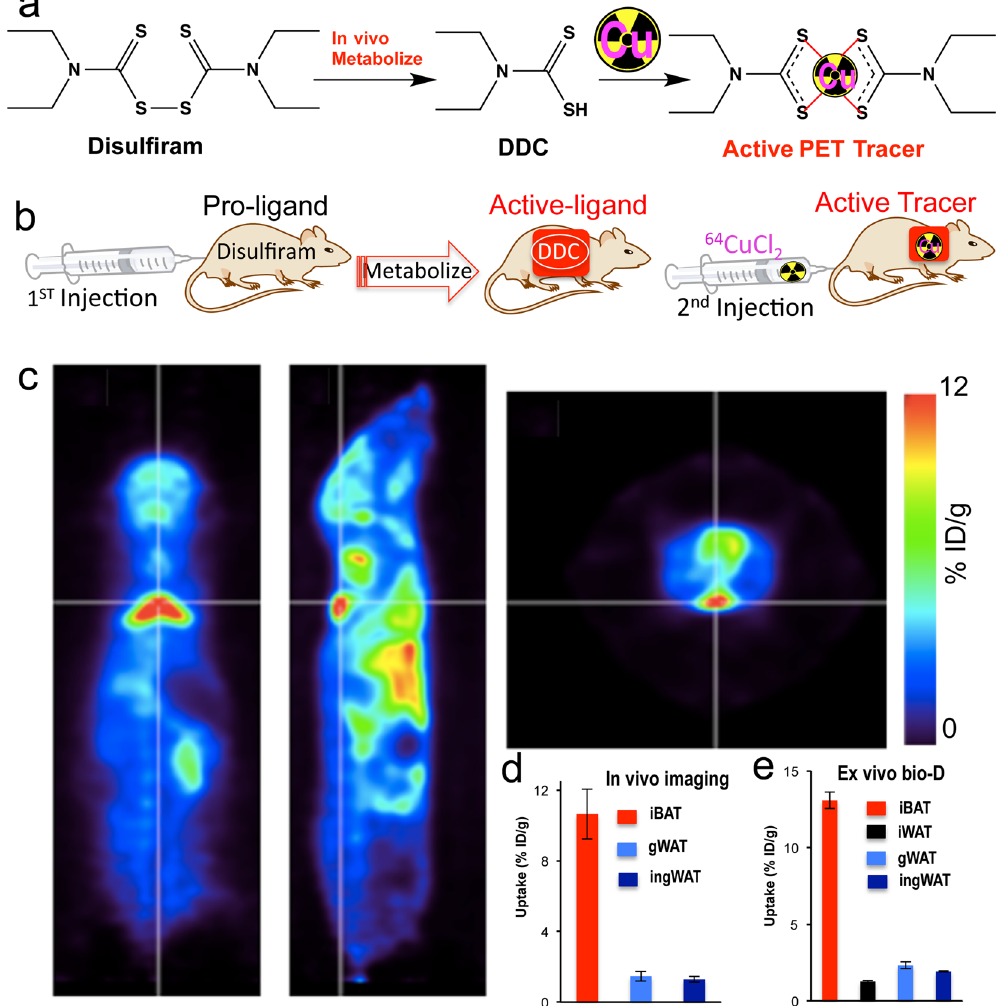
PET images of a mouse injected consecutively with Disulfiram and 64 CuCl 2 ( 64 Cu-Dis) 30 minutes after 64 CuCl 2 injection. Coronal view (left), sagittal view (right), and transverse view (upper corner). The triangular shape of BAT can be easily identified. ( d ) Quantitative analysis of the tracer uptake from in vivo imaging with 64 Cu-Dis in interscapular BAT (iBAT), gonadal WAT (gWAT) and inguinal WAT (ingWAT). ( e ) Ex vivo bio-distribution of the tracer in iBAT, interscapular WAT (iWAT), gWAT and